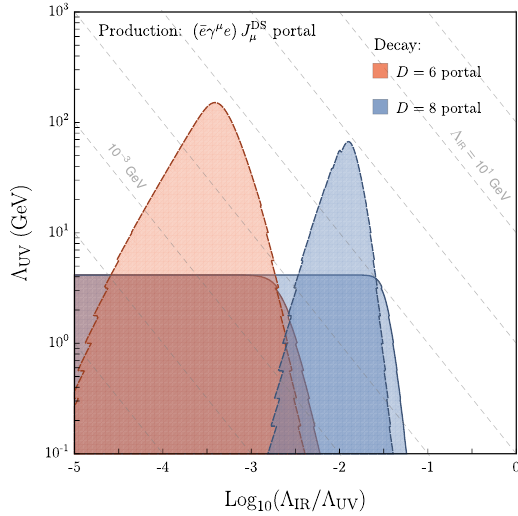
Figure 11 . Constraints from NA64 (solid contours) and E137 (dashed contours) on elusive dark sectors with portal (¯ eγ µ e ) J DS . The plot assumes a strongly-coupled DS dynamics and two possible µ portals mediating the LDSP decay, respectively with dimension D = 6 (blue region) or D = 8 (red region). For both portals, κ 2 c is set to